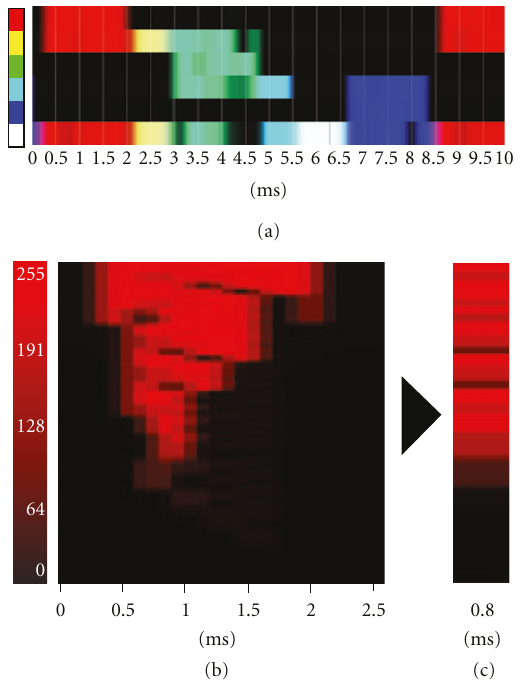
Figure 11: Color wheel analysis of the Acer P3250 DLP projector. (a) is the overall color-wheel sequences as seen by the synchronized camera with starting exposure times ranging from 0 to 10 ms. (b) is detailed mirror flip sequences for all 256 values in the red channel with the starting exposure times ranging from 0 to 2.5 ms. (c) is mirror flip sequences at the selected starting exposure